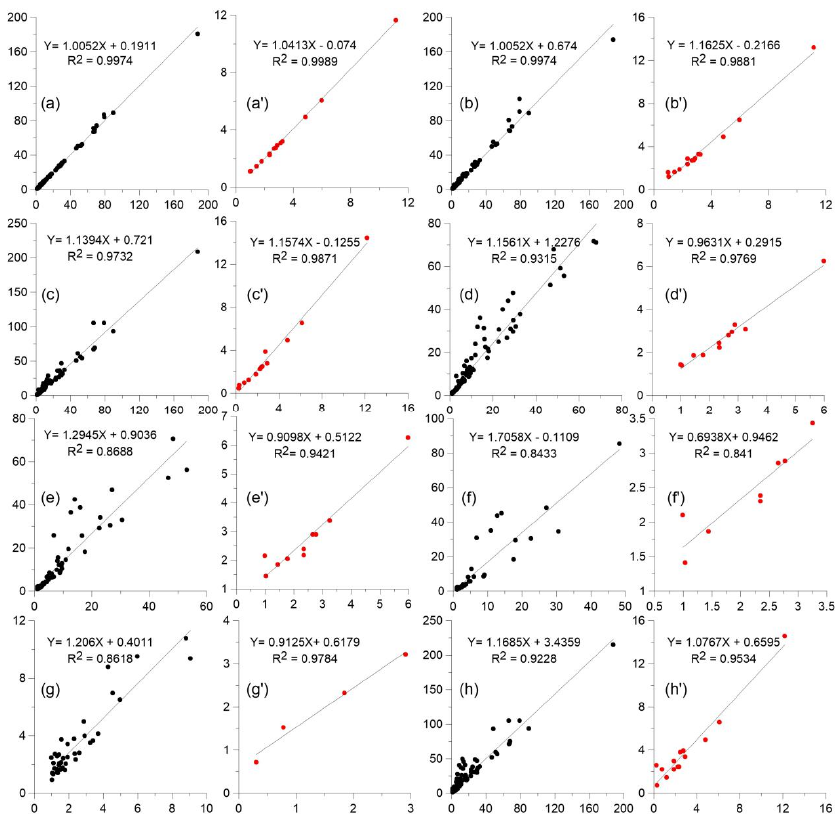
Figure 4. Fitting relationships between the SSCs of the surface layer (horizontal axis) and the other layers (vertical axis, ( a ) surface layer and 5 m layer, ( b ) surface layer and 10 m layer, ( c ) surface layer and 15 m layer, ( d ) surface layer and 20 m layer, ( e ) surface layer and 25 m layer, ( f ) surface layer and 30 m layer, ( g ) surface layer and 40 m layer, ( h ) surface layer and bottom layer; black points represent all stations; red points represent the Bohai Strait stations).